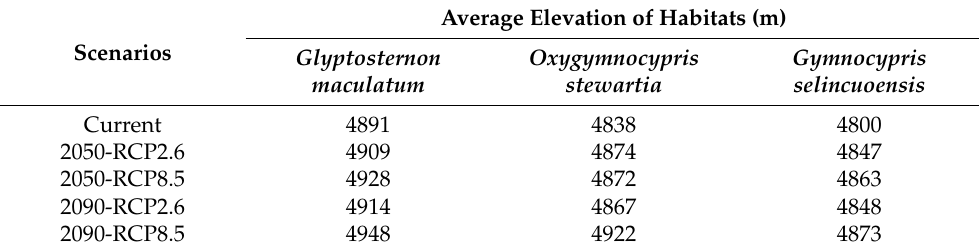
Table 3. Average elevation of habitats of three species under four